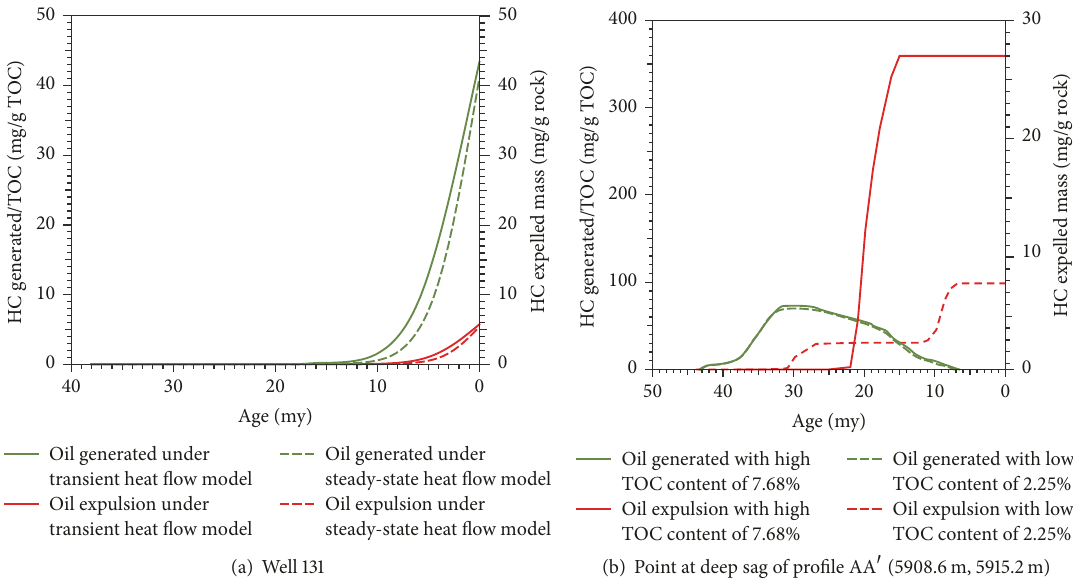
Figure 24: Sensitivity analysis of heat flow model (a) and TOC content in the Huizhou Sag (the location of well 131 is shown in Figure